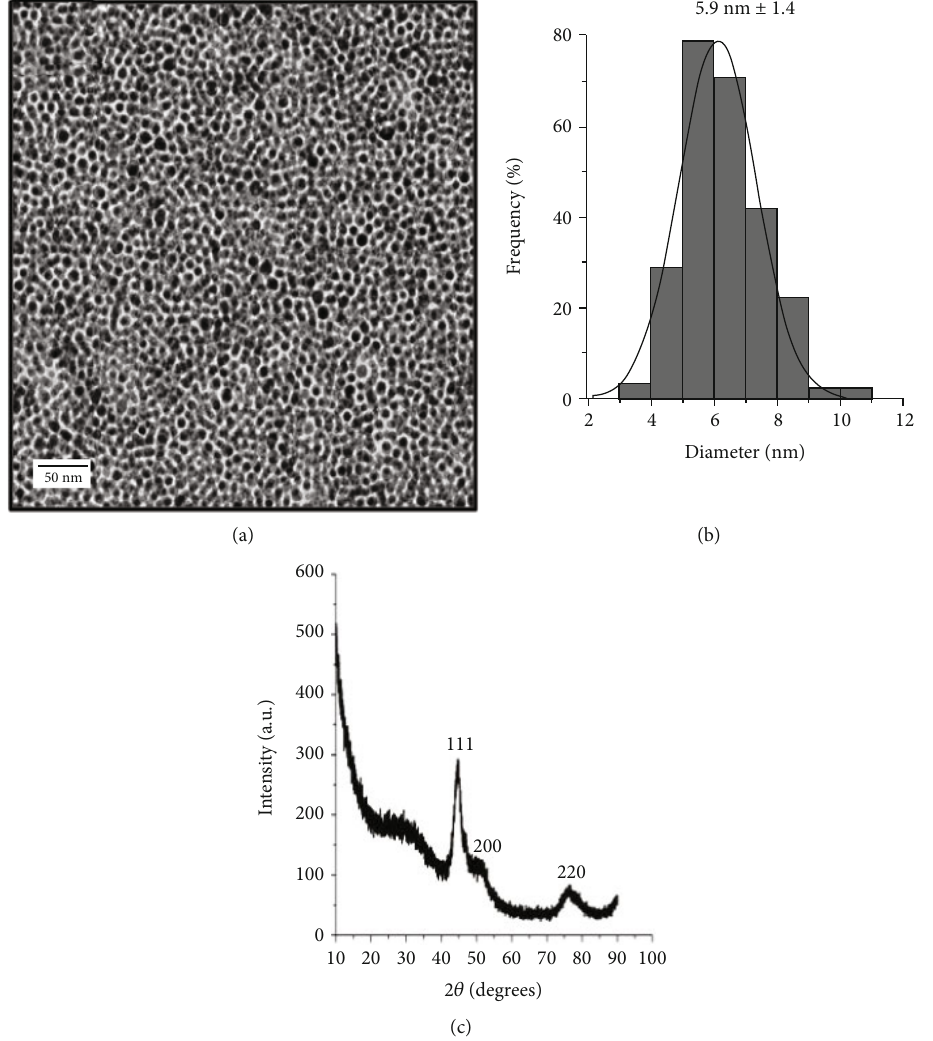
Figure 2: TEM image (a), size distribution (b), and XRD patterns (c) of Ag